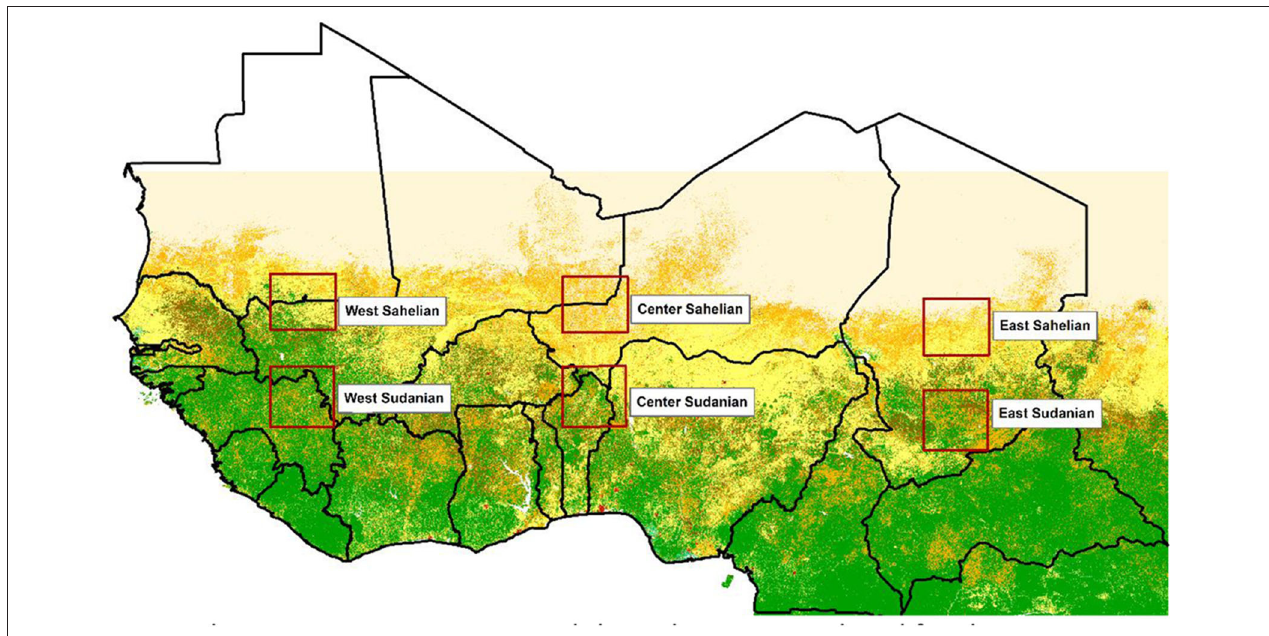
FIGURE 1 | The S2 prototype LC map and the polygons considered for the assessment.